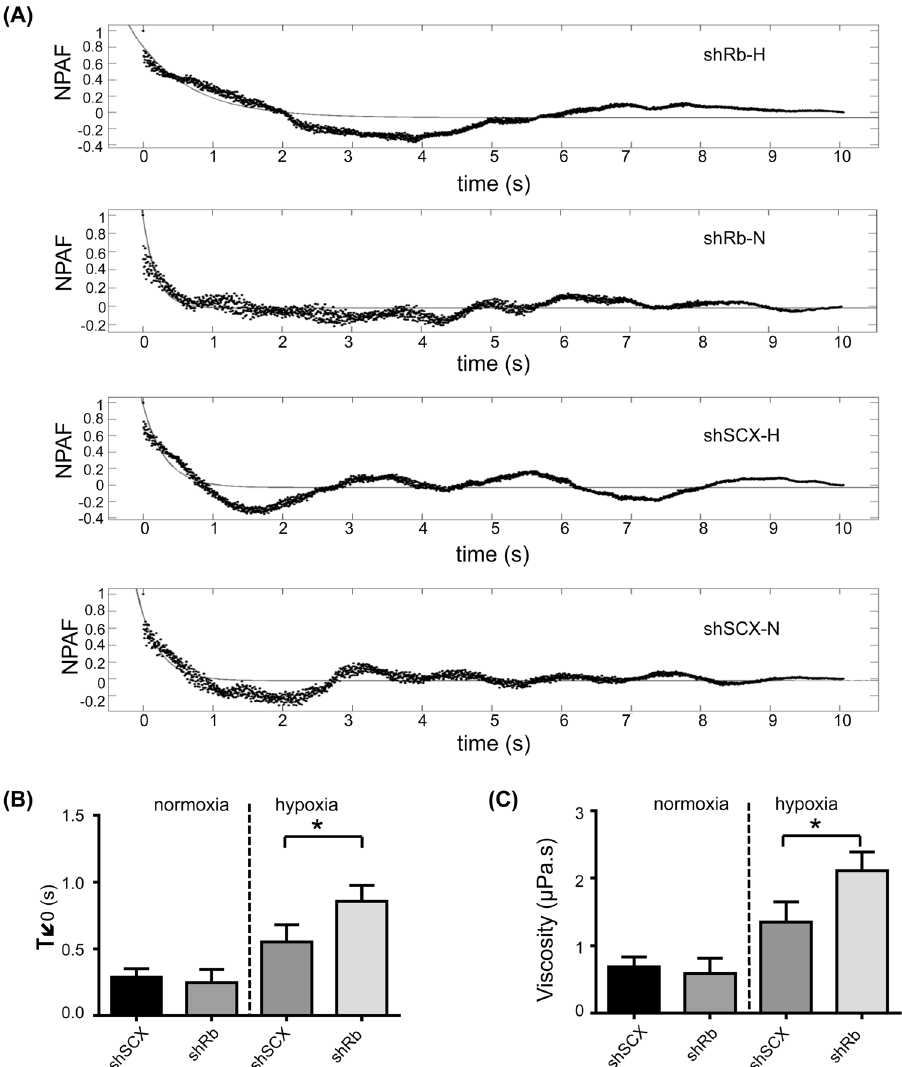
Figure 2. Exposure to hypoxia causes alterations in normalized position autocorrelation function (NPAF) in prostate cancer cells. ( A ) Normalized position autocorrelation function of beads fluctuations along with their exponential fit for shRb and shSCX LNCaP cells after 72 h of exposure to hypoxia or normoxia. ( B ) Relaxation time variation between different groups of cells (shRb, shSCX) after 72 h of hypoxia or normoxia. ( C ) Estimated viscosity from the measured relaxation time for different groups of cells (shRb, shSCX) after 72 h of hypoxia or normoxia. For A – C experiments were repeated 4 times (n = 4) and 10 cells were manipulated for each determination. Error bars represent ± S.D. * p <